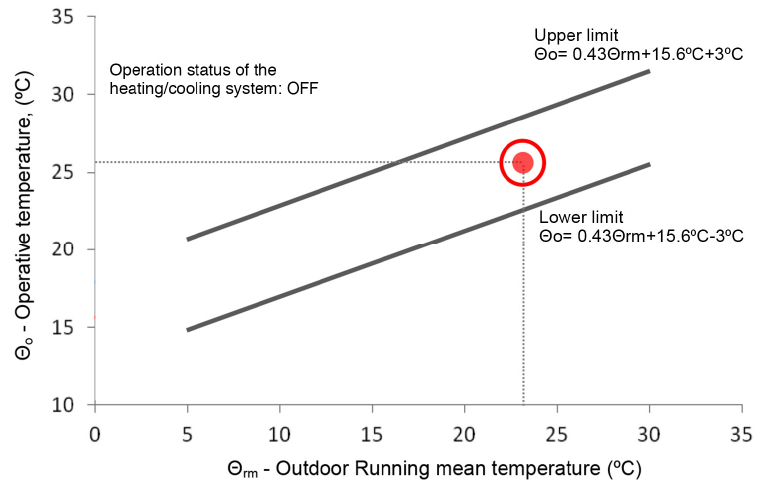
Figure 13. Thermal comfort temperature (operative temperature) in the living room during summer monitoring, based in the relation between the limits of the indoor operative temperature ( Θ o ) for buildings without mechanical air-conditioning systems as a function of the exponentially-weighted running mean of the outdoor temperature ( Θ rm ) (adapted from